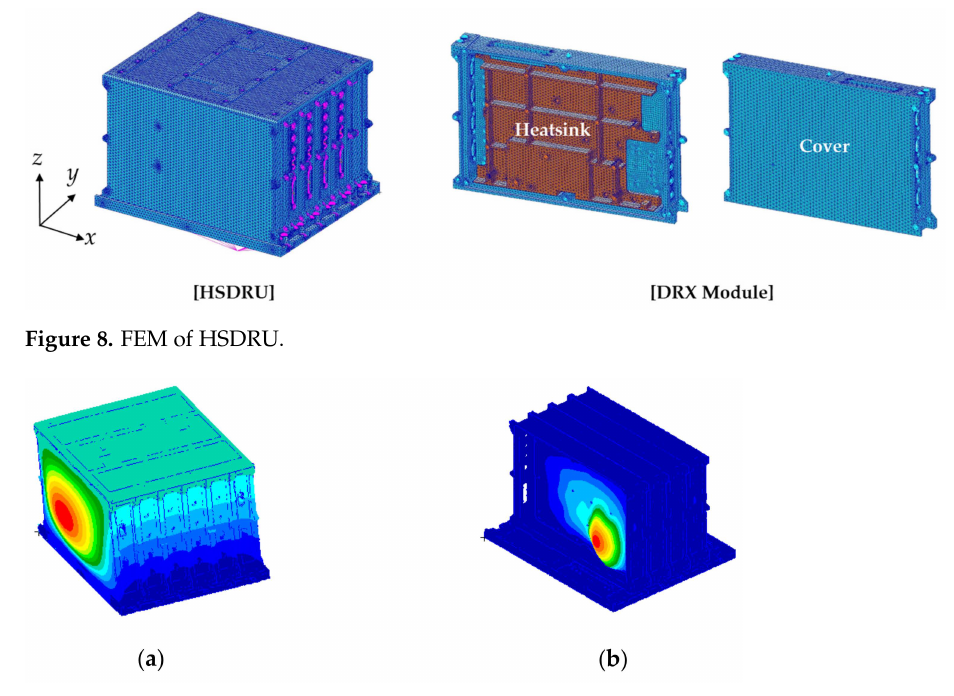
Figure 9. Modal analysis results of HSDRU. ( a ) First 338.9Hz (global bending mode). ( b ) Sixteenth 775.7 Hz (local mode, DRX heat sink).